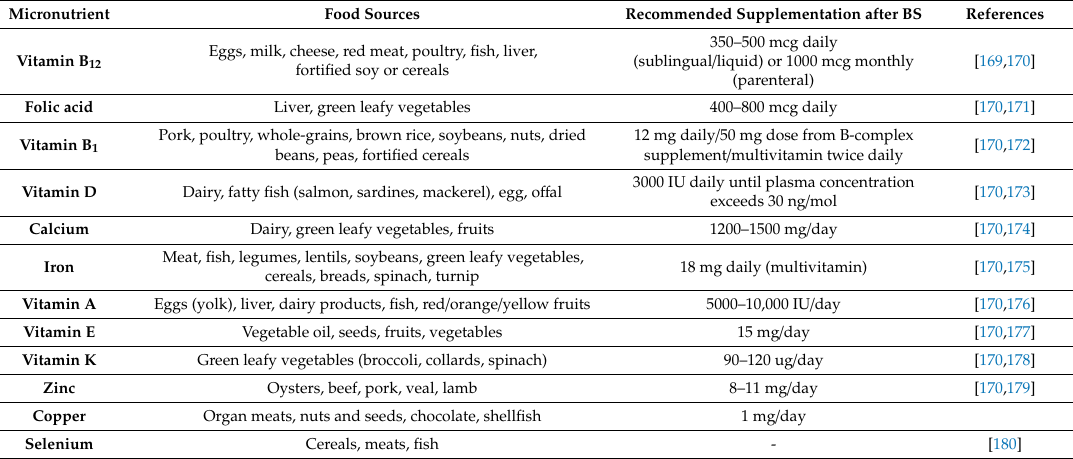
Table 3. Micronutrient deficiencies following RYGB and